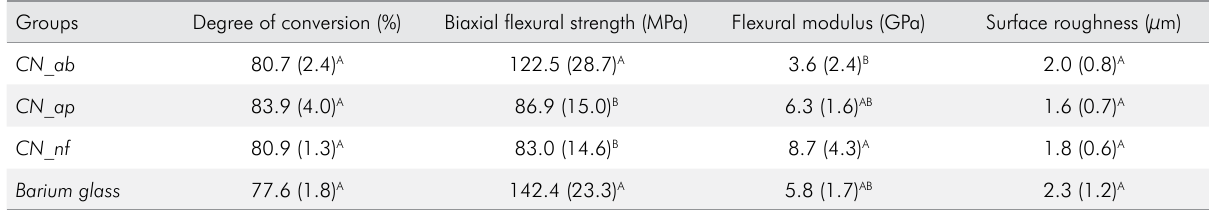
Table 2. Means, standard deviations and statistical analysis of experimental groups submitted to biaxial flexural test and roughness